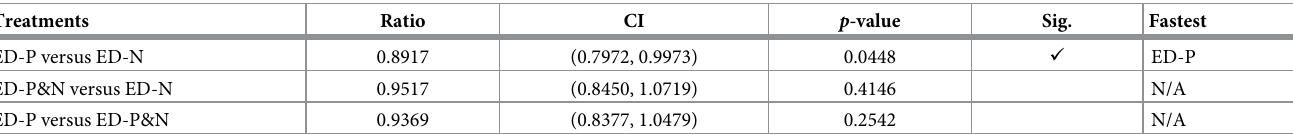
Table 8. ED : Intersection cardinality time analysis.